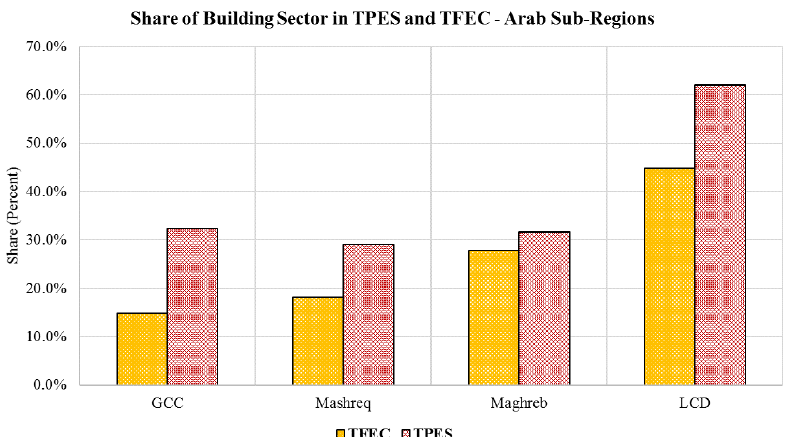
Figure 10. Share of the building sector in the Arab Sub-regions TPES and TFEC for 2015.